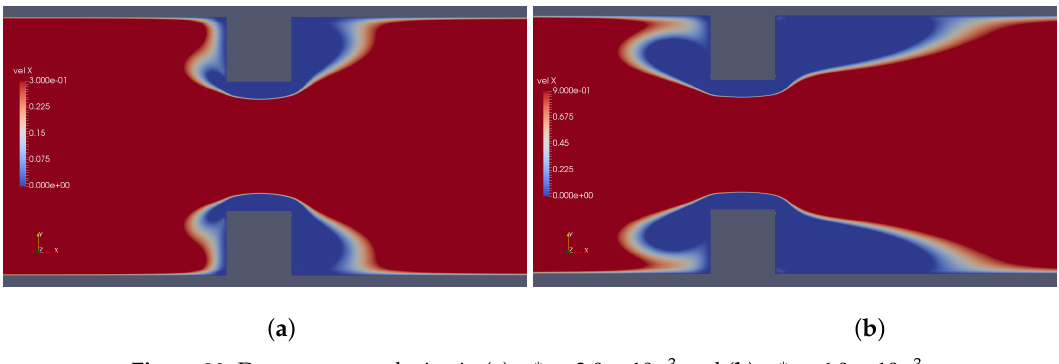
Figure 20. Downstream velocity, in ( a ) ω ∗ = 3.0 × 10 − 3 and ( b ) ω ∗ = 6.0 × 10 − 3 .